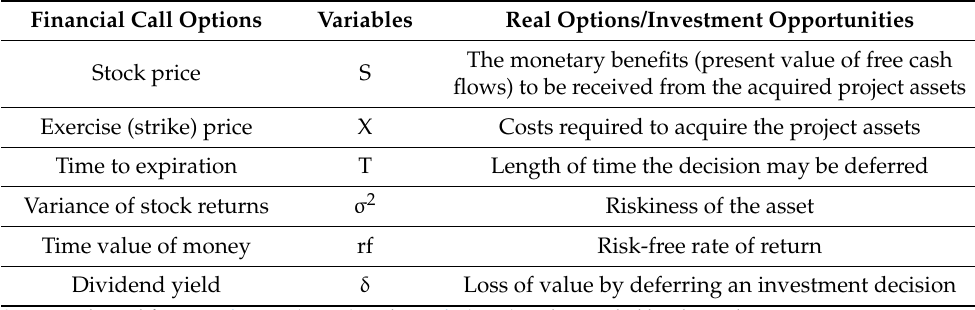
Table 1. The correspondence between financial options and real options. Financial Call Options Variables The monetary benefits (present value of free cash Stock price S Exercise (strike) price X Time to expiration T Length of time the decision may be deferred Variance of stock returns σ 2 Riskiness of the asset Time value of money rf Risk-free rate of return Dividend